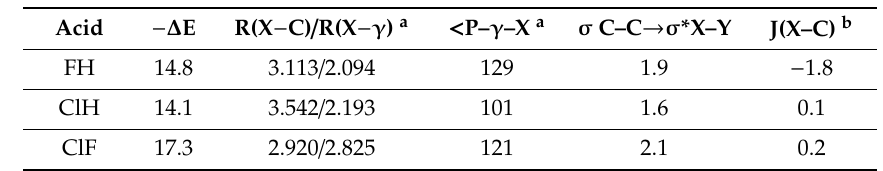
Table 2. Binding energies ( − ∆ E, kJ mol − 1 ), distances (R(X- γ ) a and R(X-C), Å)), angles P- γ -X a ( < , o